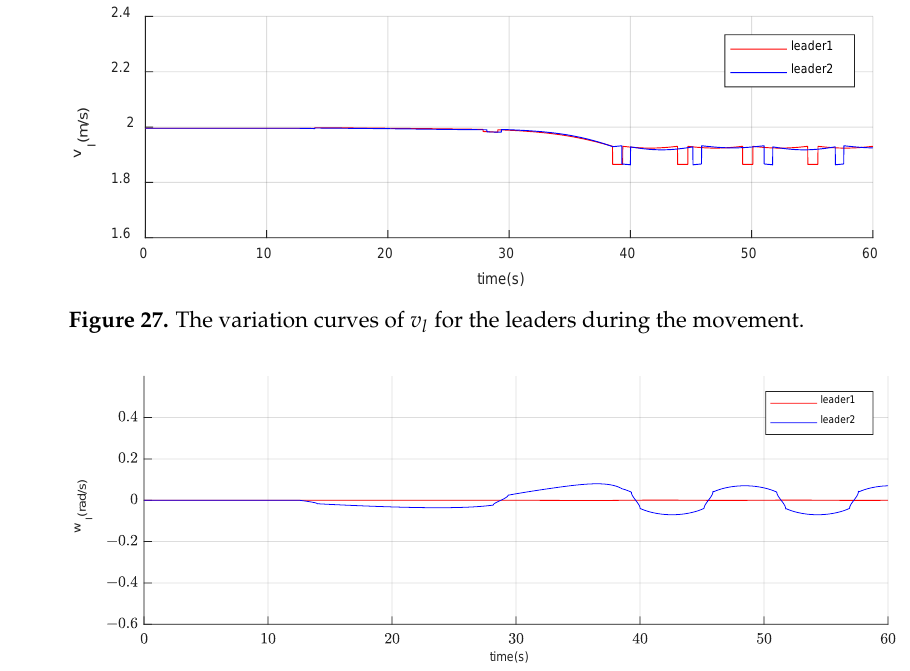
Figure 28. The variation curves of ω l for the leaders during the movement.